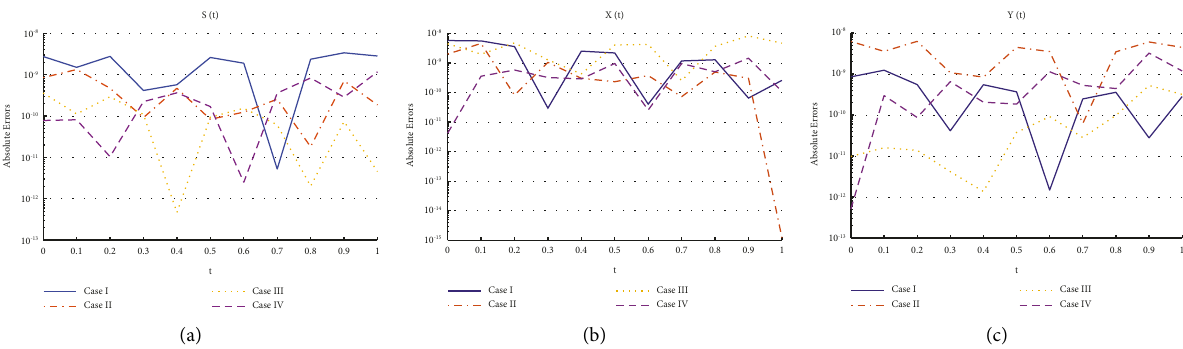
Figure 16: Absolute errors obtained by the LeNN-WOA-NM algorithm under the influence of variations in c the prey-predator model. (a) Population density of local prey. (b) Population density of immigrant prey. (c) Population density of the predator.